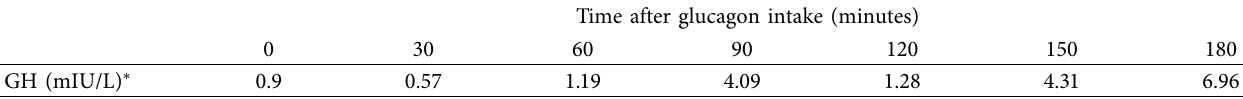
Table 3: Growth hormone stimulation test findings following glucagon